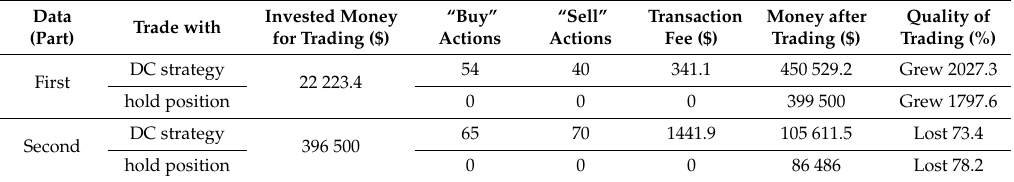
Table 2. Main information about the trading process for the first part (increasing